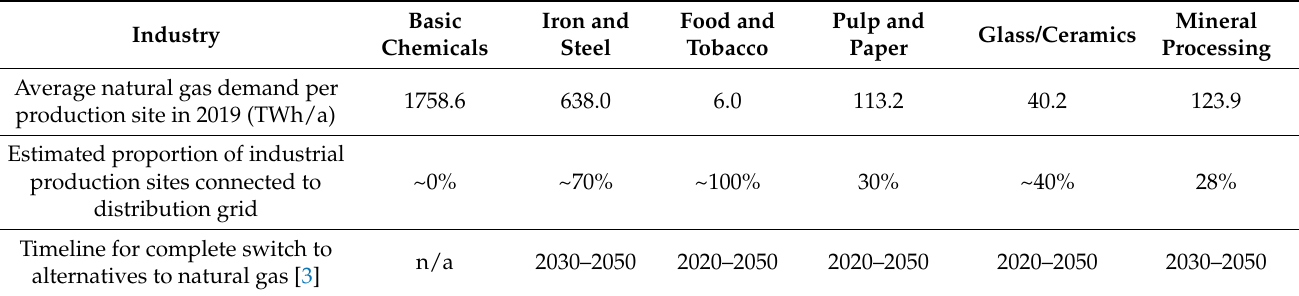
Table 4. Summary of findings (produced by the